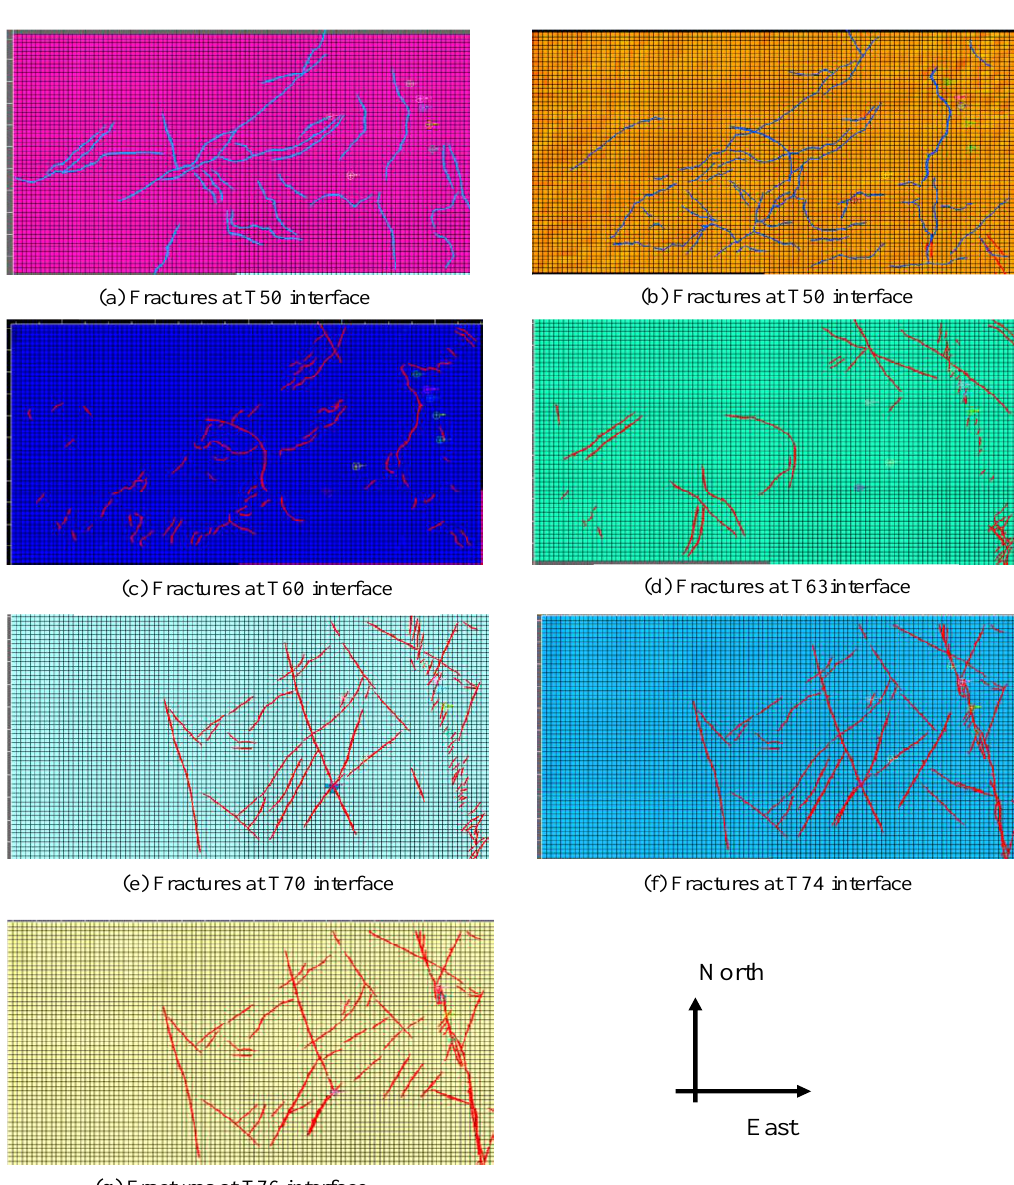
Figure 3. Plane view of distribution of natural fractures in each layer obtained from seismic data interpretation.